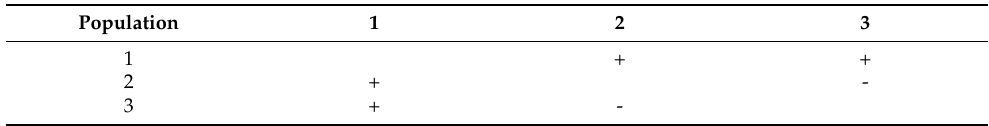
Table 6. FST pairwise comparison of populations using paired t -tests. Significance matrix FST ( p =